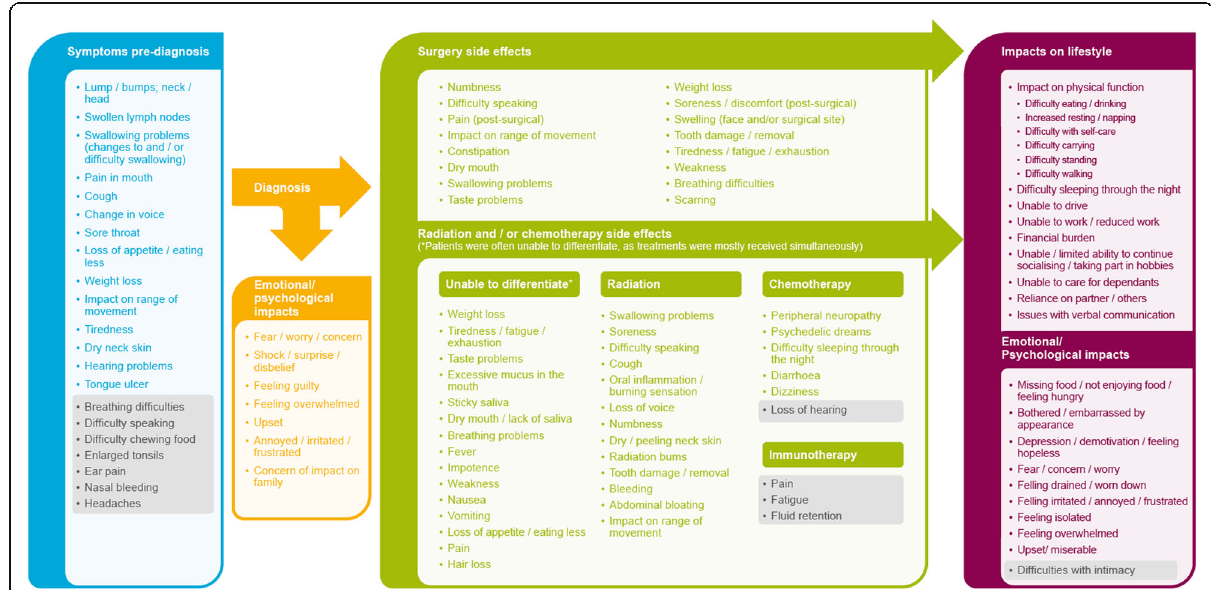
Fig. 3 Conceptual model of HNSCC patient experience. The conceptual model was cross-checked with the results of the medical expert interviews. Additional concepts reported by the experts were added to the conceptual model where these were not reported by patients during the concept elicitation interviews (highlighted in the grey boxes). Note: Although immunotherapy is included in the conceptual model, data on side effects experienced is limited by the small number of patients ( n = 2) receiving this treatment (as part of a clinical trial) and by the fact that they did not attribute any specific side effects to this treatment